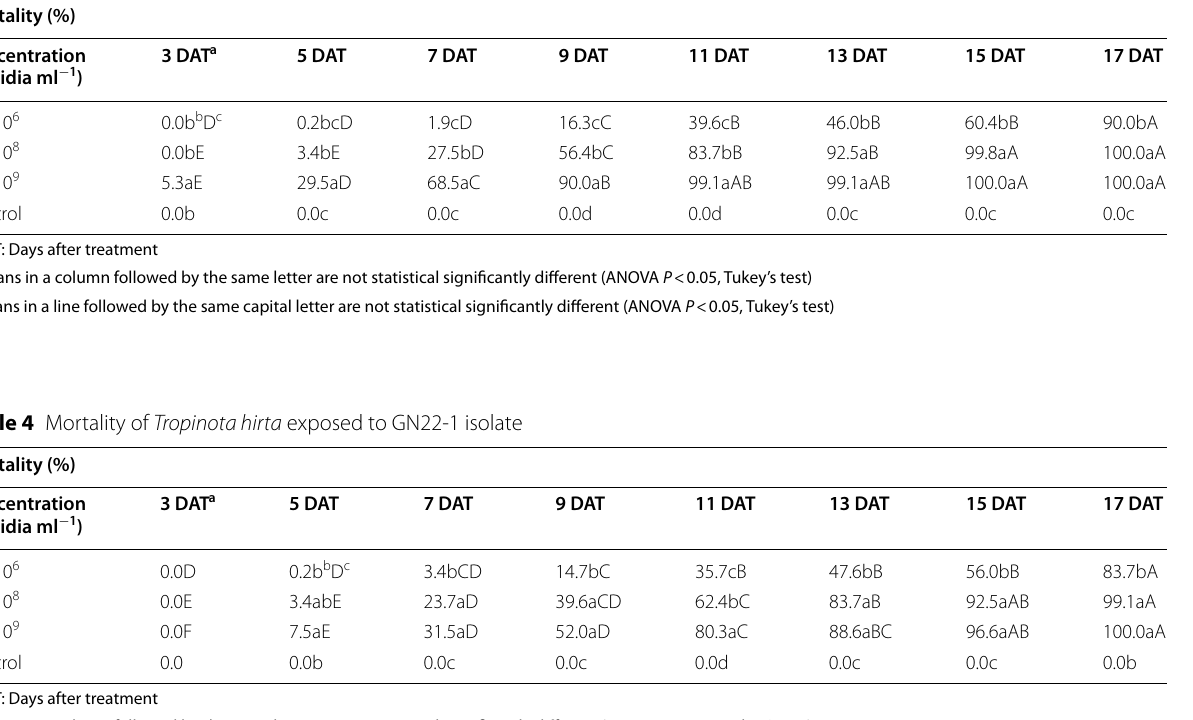
Table 3 Mortality of Tropinota hirta exposed to GN16 isolate